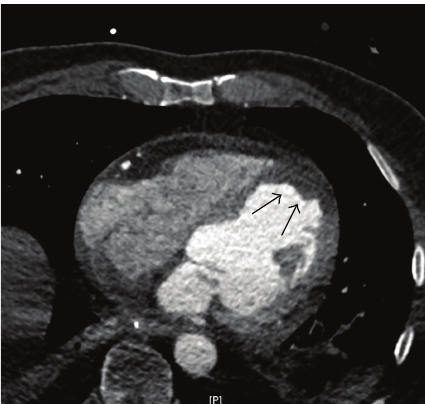
Figure 7: Contrast enhanced ECG-gated chest computed tomo- graphic scan showing loosening of the myocardial anteroapical wall as well as thrombus formation (black arrow).